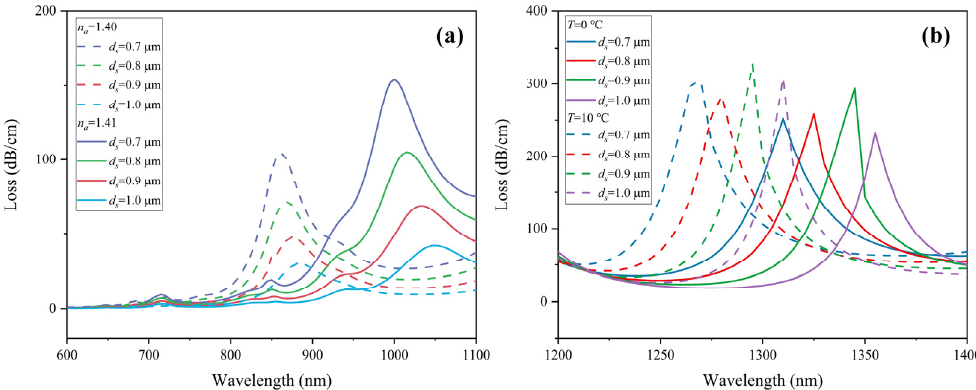
Figure 10. Loss spectra of ( a ) y- polarization core mode in RI sensing channel when analyte RI varies from 1.40–1.41, and ( b ) x- polarization core mode in temperature sensing channel under ambient from 1.40–1.41, and ( b ) x -polarization core mode in temperature sensing channel under ambient temperature from 0–10 °C with different diameter of air holes d s . temperature from 0–10 ◦ C with different diameter of air holes d s